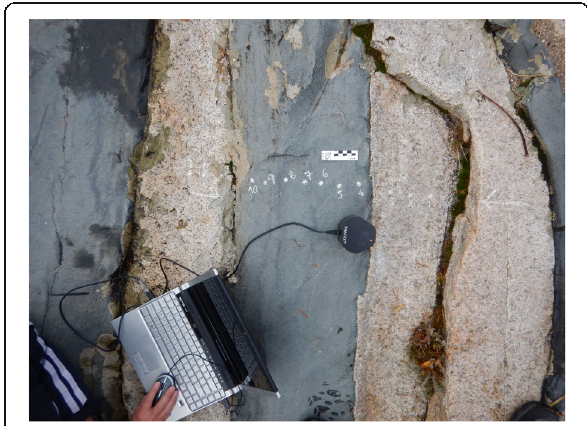
Fig. 4 Innowep TraceIT optical rugosimeter. The acquisition unit (centre) contains the three collimated light beams and cameras that allow a photogrammetric reconstruction of a 5 × 5 mm area. North is on the right of the